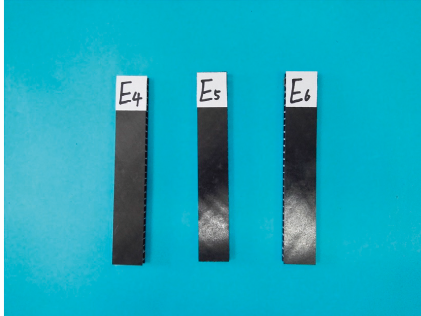
Figure 6: Specimens before quasistatic three-point bending test with different loading